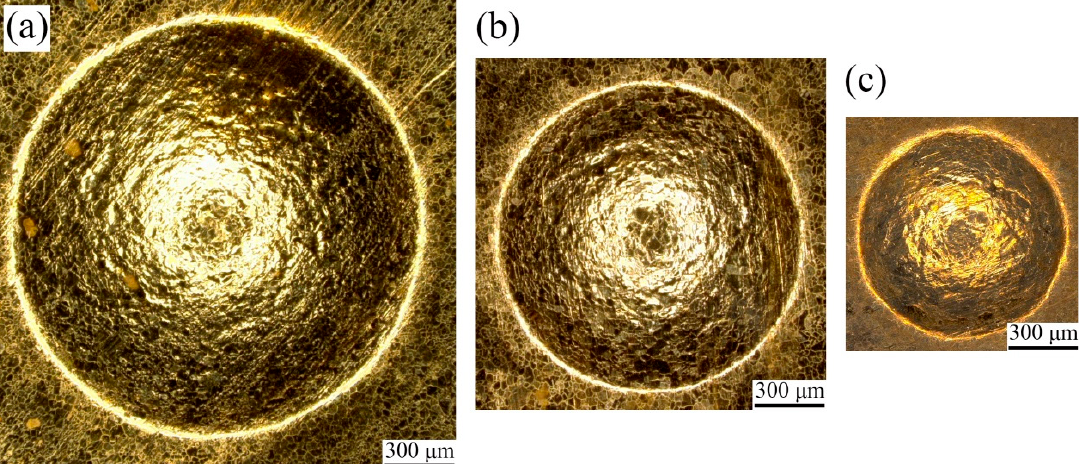
Figure 5. Topography of coarse ‐ grained bulging samples under laser pulse energy of 363 mJ. ( a ) λ = 1 ( b ) λ = 0.5 ( c ) λ = 0.25.